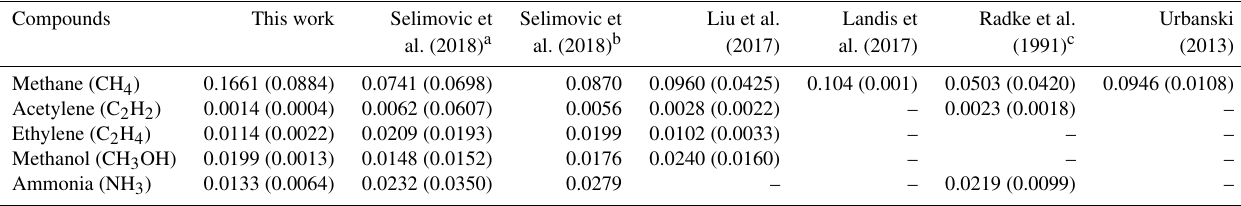
Table 1. Time-weighted study-average enhancement ratios (ratioed to CO) compared to emission ratios reported in other studies. Compounds This work